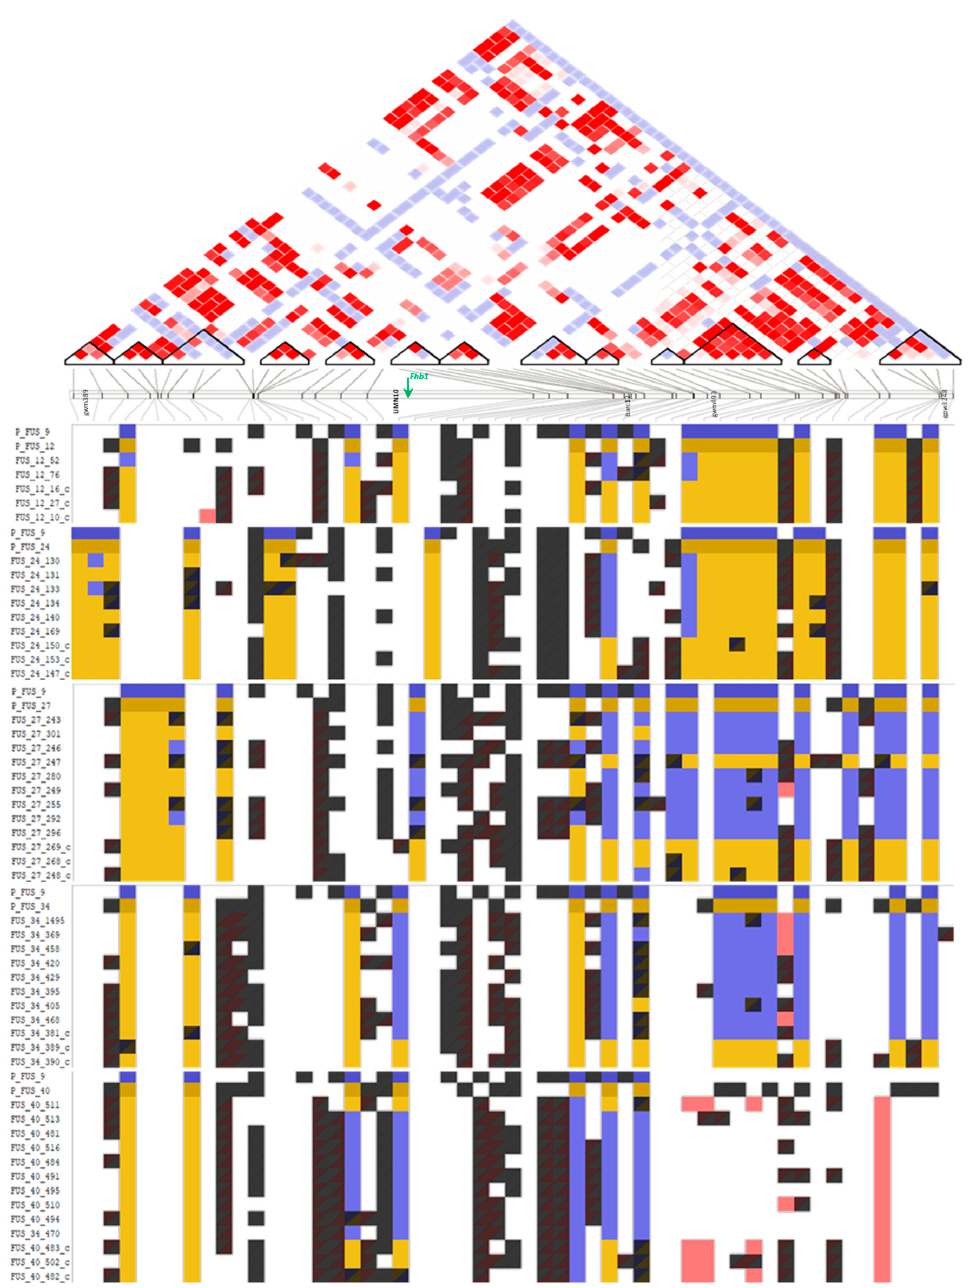
Figure 4. Schematic representation of LD plot and haploblocks (black triangles) detected on 3BS chromosome fragment (0.7–23.1 Mb) with estimated SSRs marker (black) and Fhb1 locus (green arrow) location; the red color indicates the high level of LD. Below the DArT-SNP allele distribution in five wheat families and parental lines; the blue indicates the resistant parent allele, the yellow part correlates with the RP allele; pink indicates a novel allele not represented in parental lines; the remaining one indicates a common allele for both parental lines.